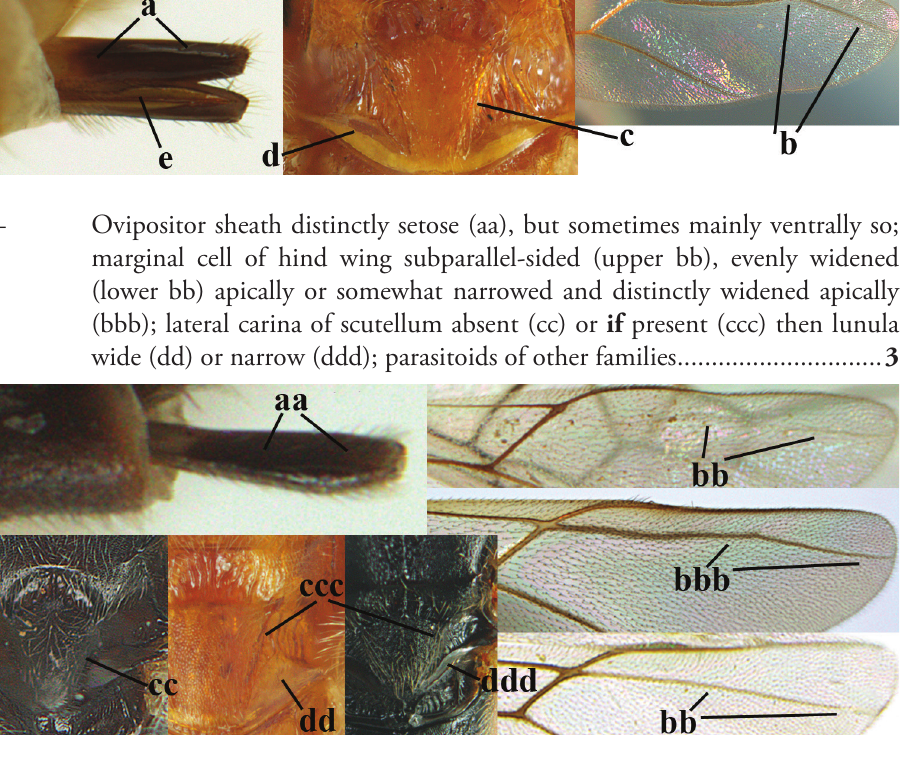
Apical half of marginal cell of hind wing distinctly gradually widened, its maximum width 1.6 × its width near hamuli or wider (a), if largely parallel- sided (aaa) then tarsal claws with coarse blackish pecten (b); second meta- somal tergite with wide smooth triangular area medio-basally (c); occipital carina usually reduced ventrally, not reaching hypostomal carina (d); meso- pleuron partly smooth and shiny (at least between punctures), but largely densely sculptured in A. krulikowskii and some males of A. ruficornis ; (usually macropterous, the known brachypterous specimens also belong here) ........... ......................................................................................... A. apicalis